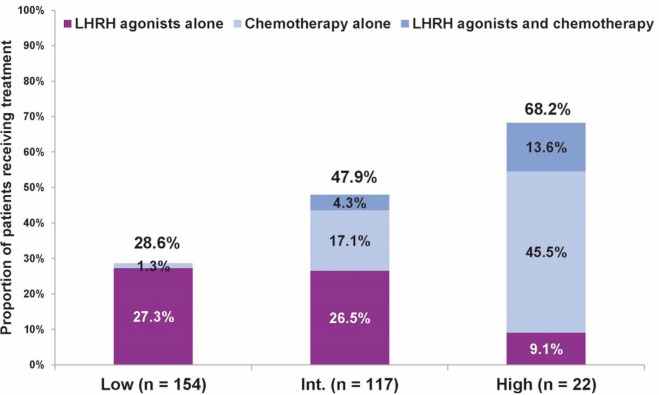
Treatment with LHRH agonists, chemotherapy, or both, in addition to tamoxifen by Recurrence Score category in patients ≤ 50 years. For treatment with LHRH agonists and/or chemotherapy: P < 0.0001 for comparing all three groups (chi-squared test).